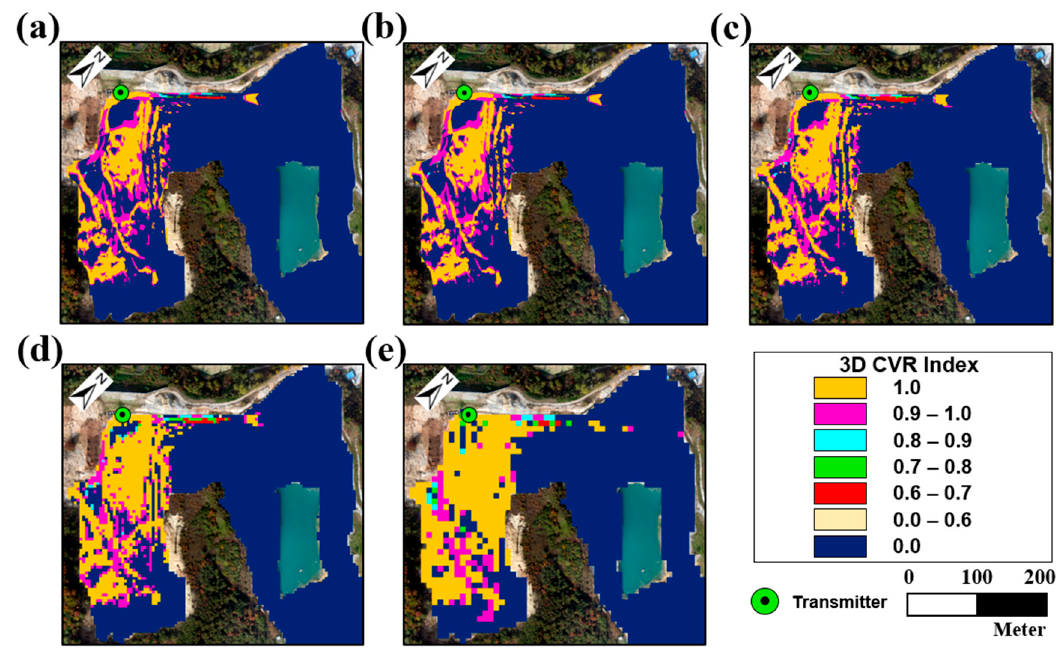
Figure 13. 3D Fresnel index maps for transmitter 1 with DSM resolutions of ( a ) 25 cm, ( b ) 50 cm, ( c ) 2 m, ( d ) 4 m, and ( e ) 8 m.